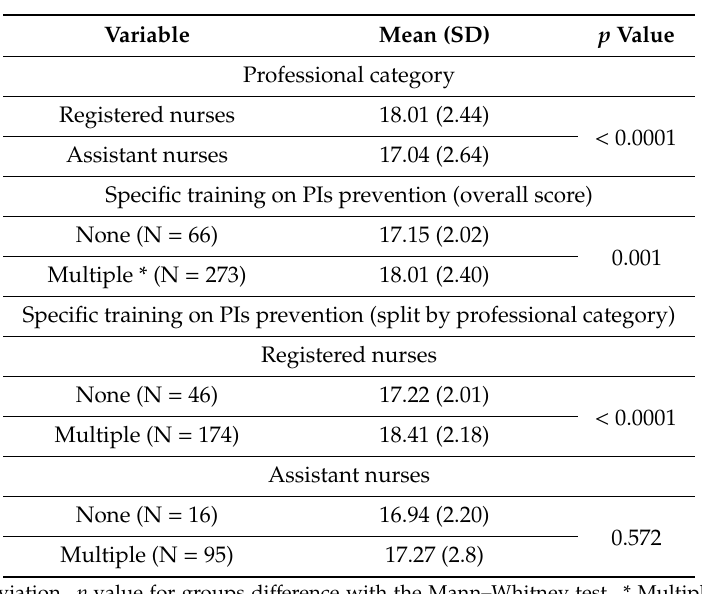
Table 5. Construct validity inknown groups.